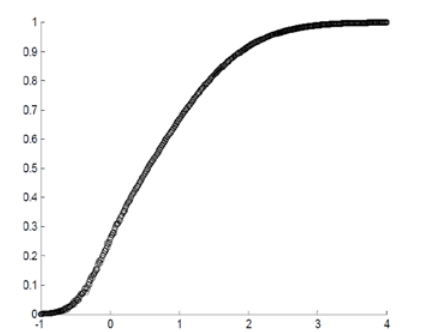
Figure 2 - Prevision index in a frequentist test case where